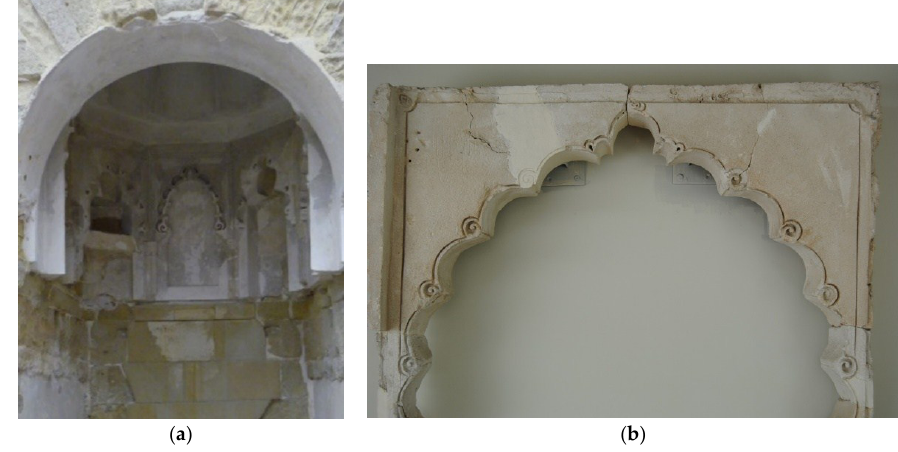
Figure 10. Interior of the mi ḥ rab of the old Aljama mosque of Almería ( a ). Photo took by author. Arch of Almohade leaves of the house no. 4 ( b ) belonging to the former Islamic settlement of Madīna Siyāsa (Cieza, Murcia). Photo took by author.